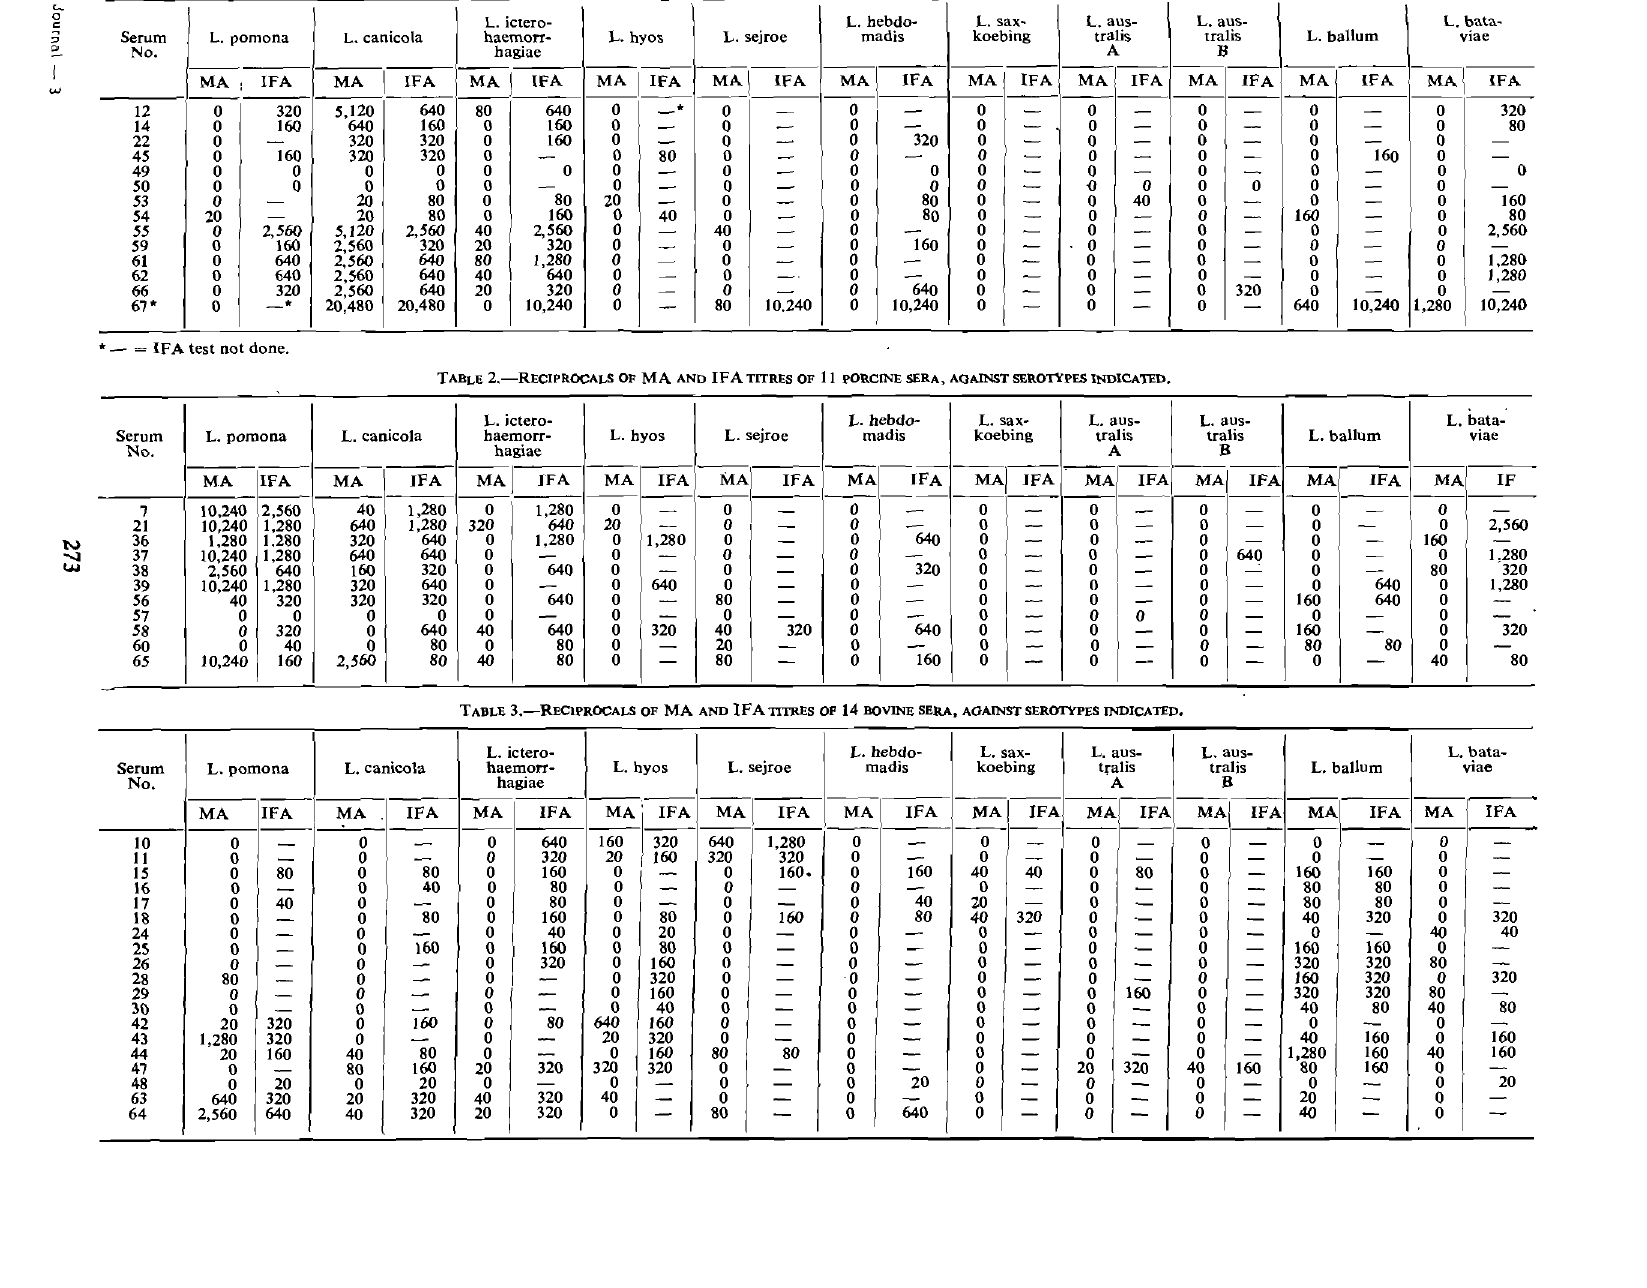
TABLE 2.-RECIPROCALS OF MA AND IFA TITRES OF 11 PORCINE SERA, AQAINST SEROrtPES INDICATED.